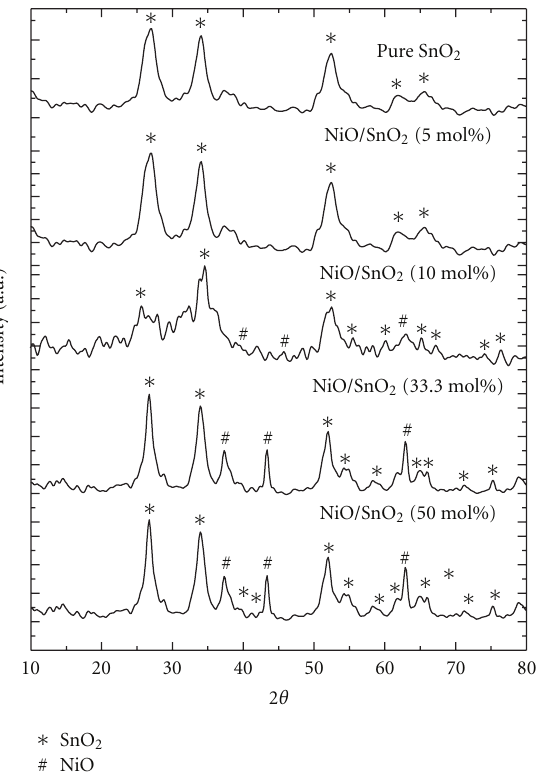
Figure 2: XRD patterns of pure and nickel-doped SnO 2 nanoparti-